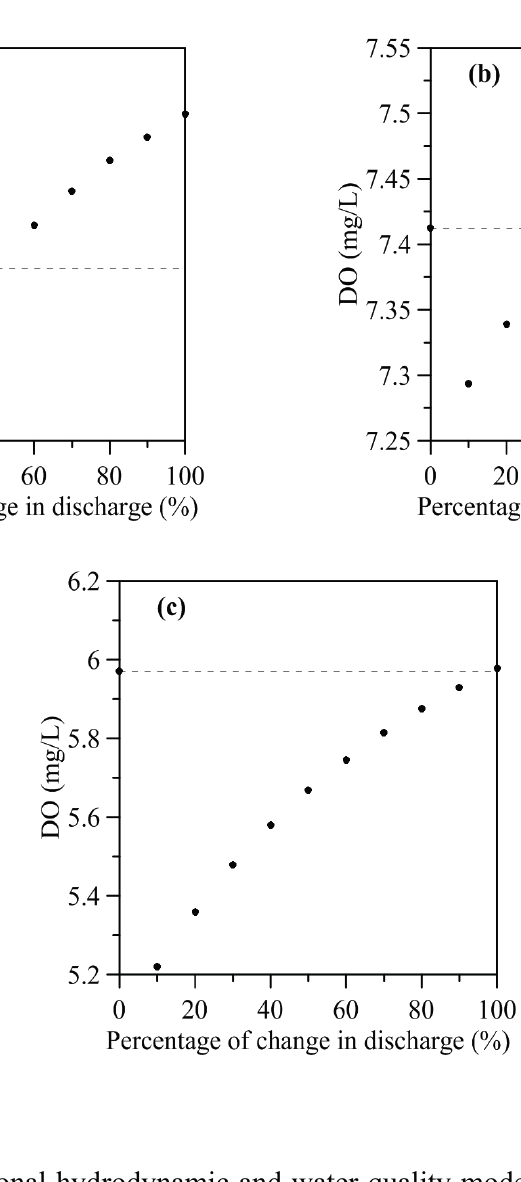
Figure 11. Predicting dissolved oxygen concentration for Scenario 3 at different locations: ( a ) Hsin-Hai Bridge; ( b ) Chung-Cheng Bridge; and ( c ) Nan-Hu Bridge. Note that the incremental ratio of the Q flow is 10% for each run. The black point represents the 75 model